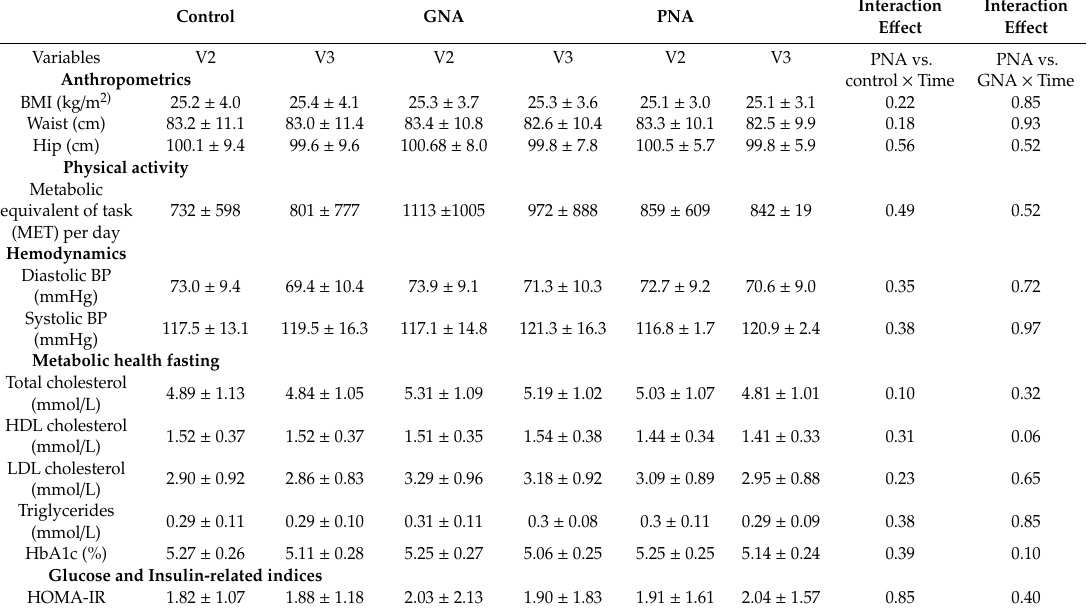
Table 2. Anthropometrics and overnight fasting blood parameters before (V2) and after (V3) the intervention period in participants receiving no nutrition advice (control), GNA or